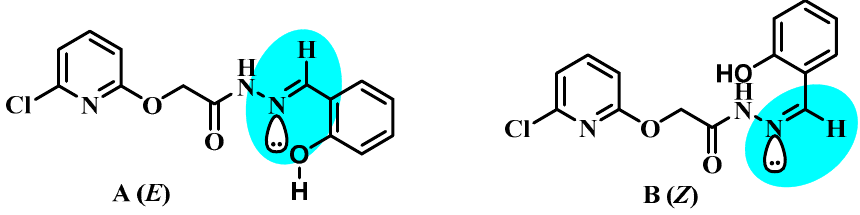
Scheme 2. Isomeric existence of the title compound. The highlighted region shows the double-bond conferring E and Z isomers.